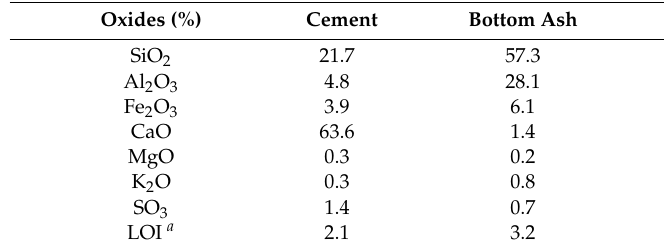
Table 1. Chemical compositions of the both used cement and bottom